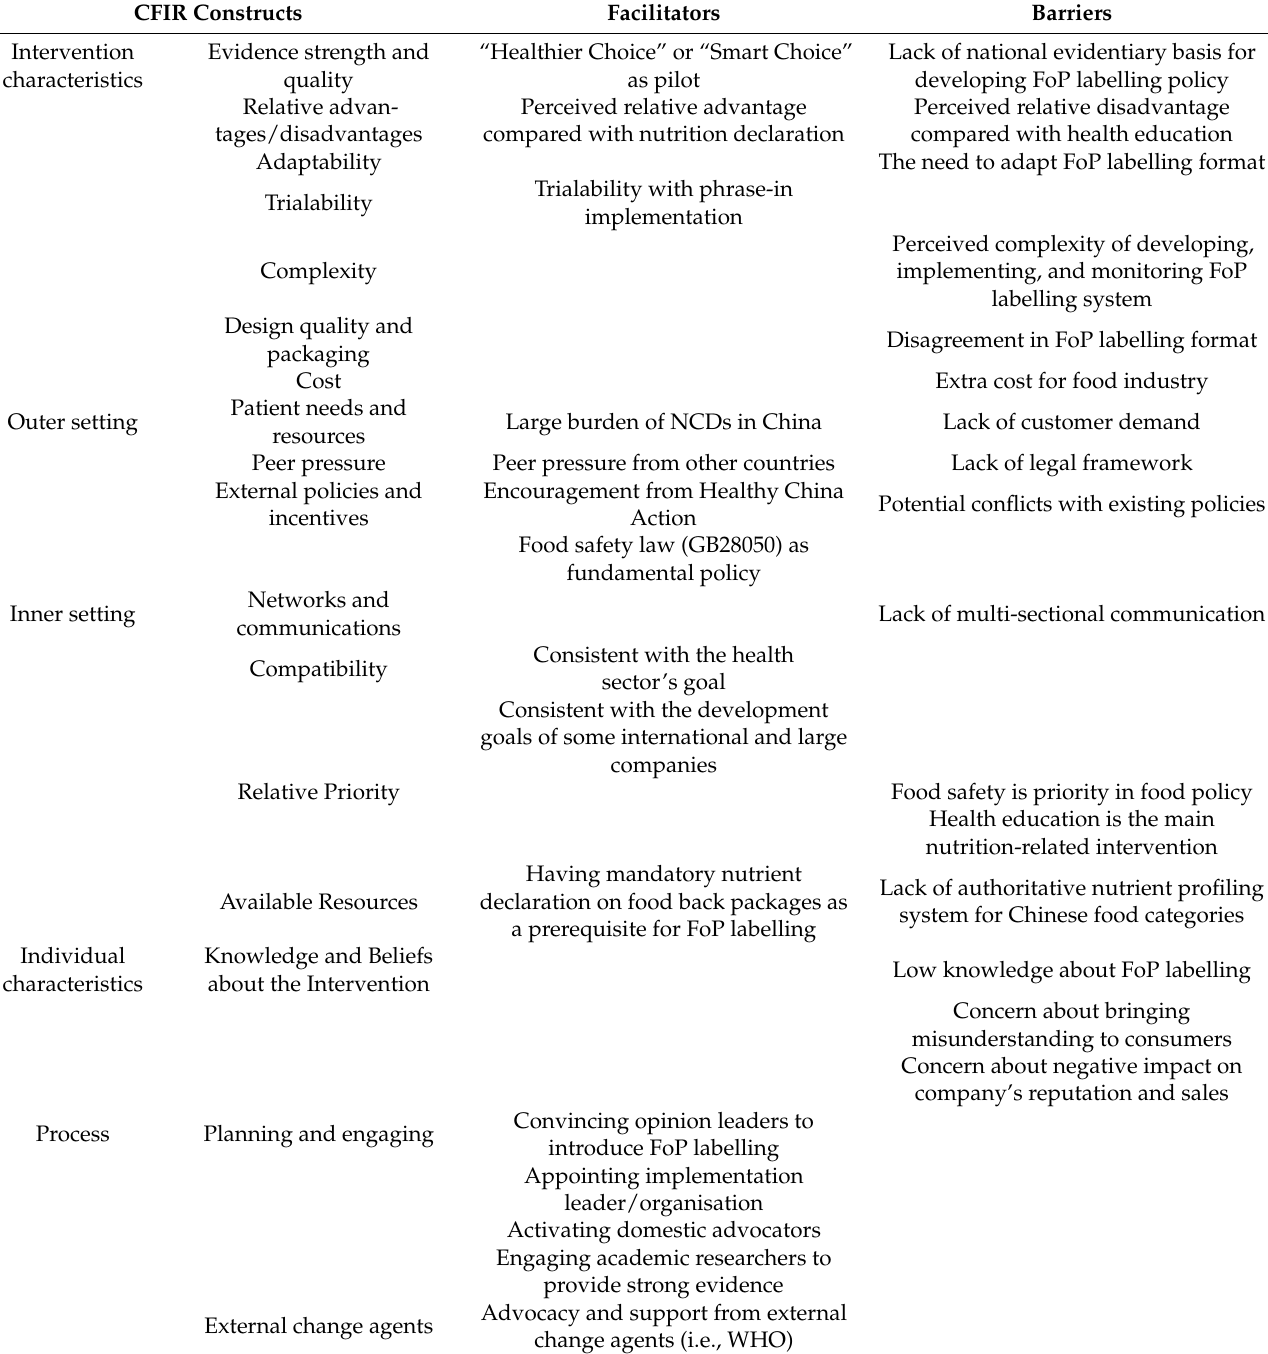
Table 1. Themes under CFIR constructs by facilitators and